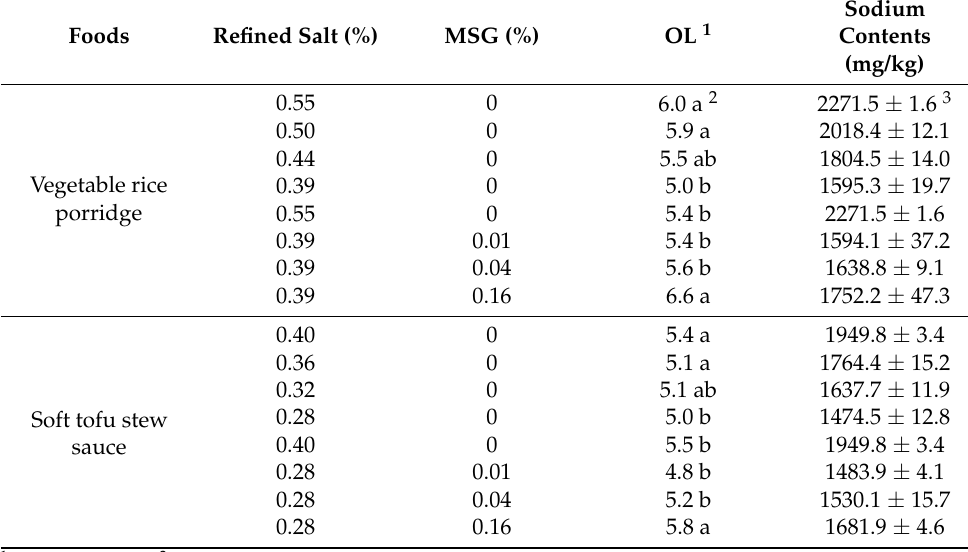
Table 1. Consumer overall liking and sodium contents of vegetable rice porridge and soft tofu stew sauce containing various concentrations of salt or salt with MSG.